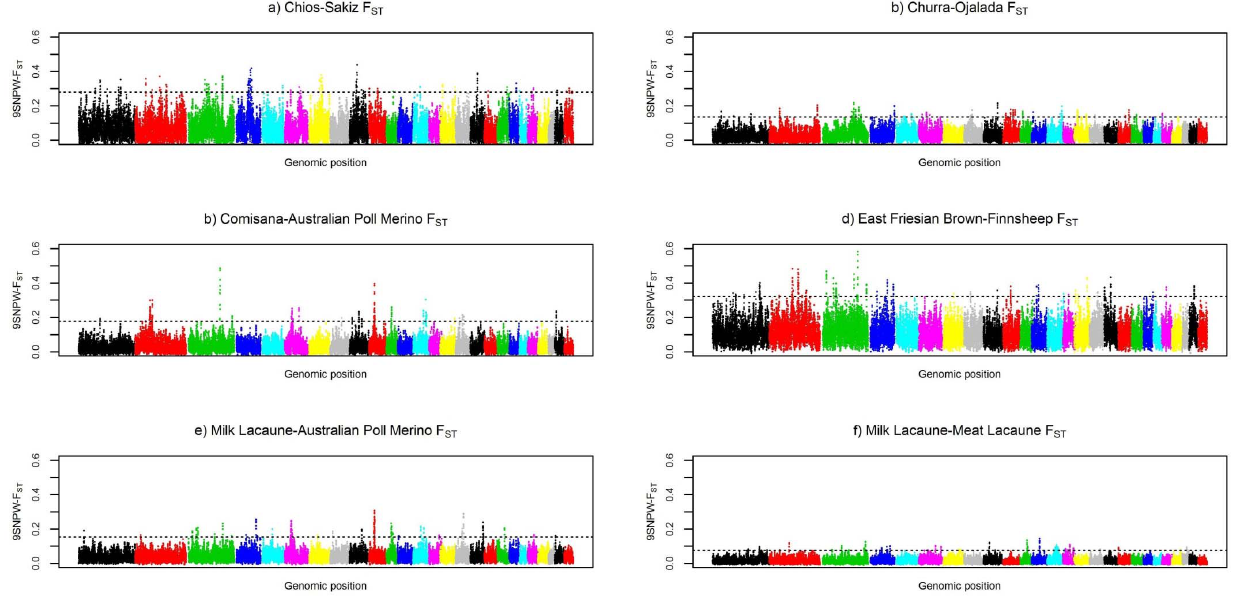
Figure 1. Genome-wide distribution of F ST values for the six analysed breed pairs. The level of genetic differentiation, measured by F ST , was estimated within each dairy – non-dairy breed pair 1 , and averaged in sliding windows of 9 SNPs (F ST -9SNPW) across the genome: The horizontal line indicates the top 0.5.th percent threshold considered for the F ST -distributions. These raw results were used to identify F ST -based candidate regions (F ST -CRs) when overlapping significant selection signals (allowing gaps up to 2-Mb) were identified between different pairs. 1 Breed pairs analysed: a) Chios-Sakiz, b) Churra-Ojalada; c) Comisana-Australian Poll Merino; d) East Friesian Brown -Finnsheep, e) Milk Lacaune-Australian Poll Merino f) Milk Lacaune-MeatLacune.